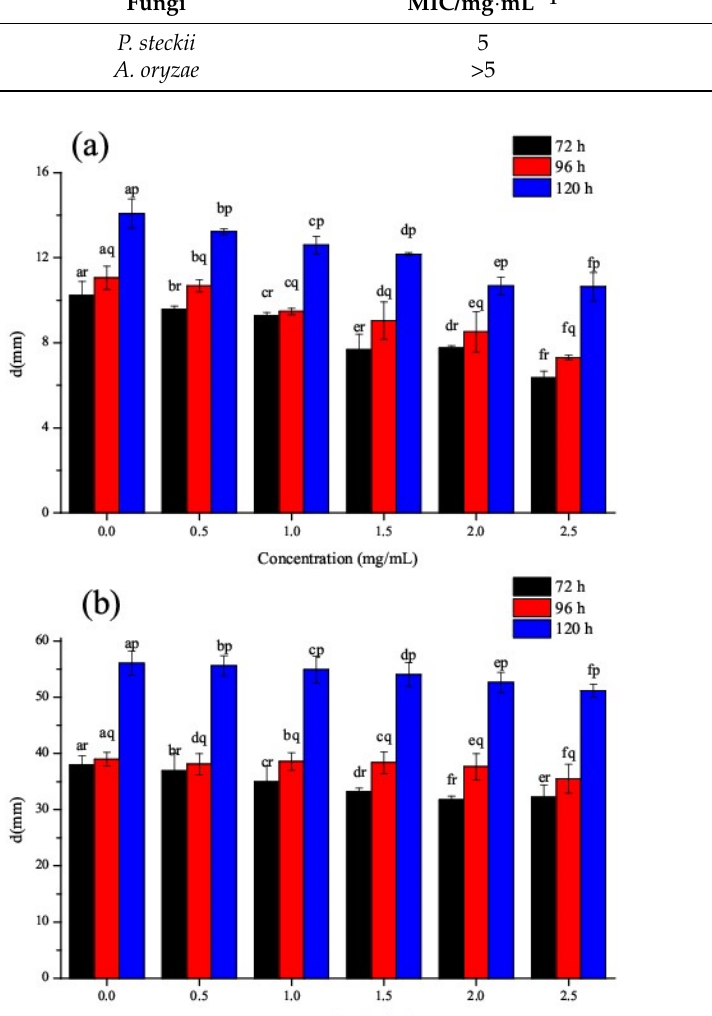
Figure 7. Effect of gradient concentrations of CSNP solutions (mg/mL) on mycelial growth of ( a ) P. steckii and ( b ) A. oryzae after 72, 96, and 120 h of